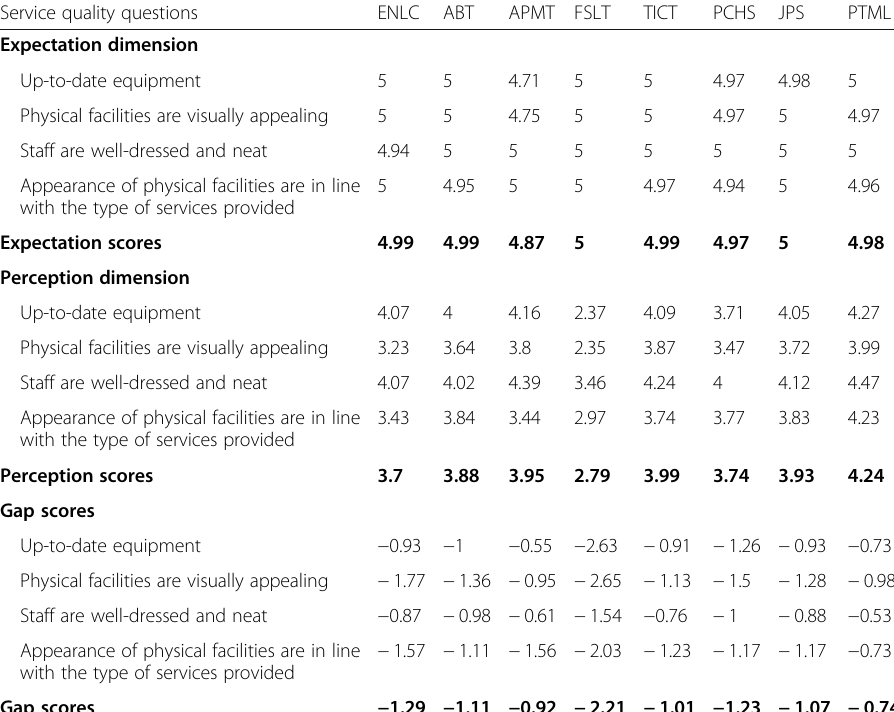
Table 4 Service quality expectation and perception average scores for tangibility Service quality